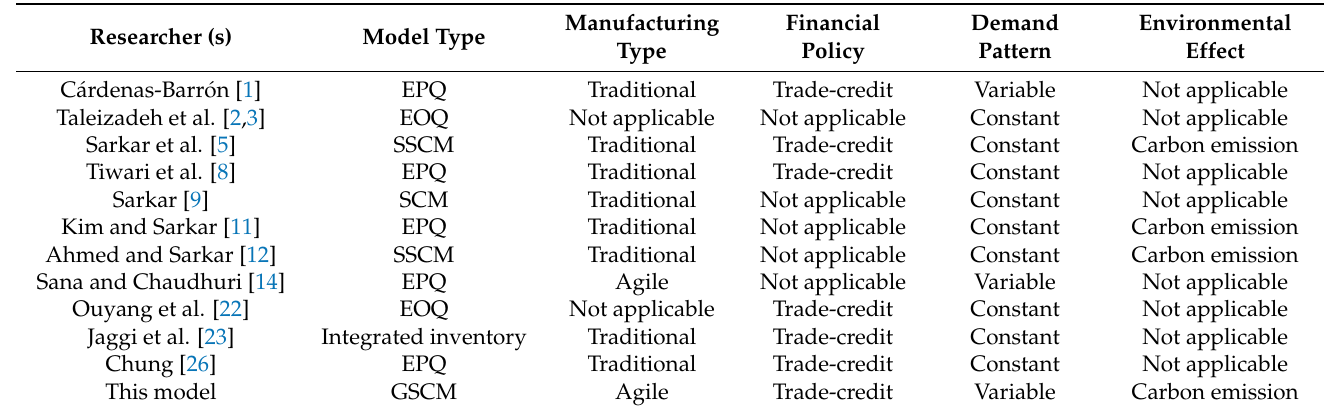
Table 1. Contribution from various